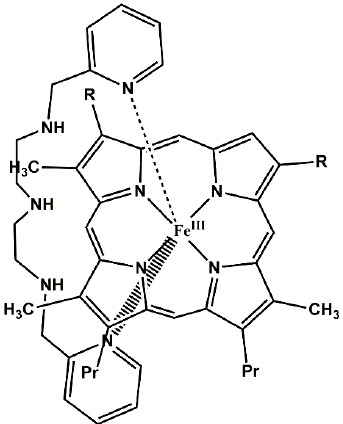
Figure 1. Pinch-porphyrins. When R = –CH=CH 2 FePPPic; R = –CH 2 –CH 3 FeMPPic and -H FeDPPic. Pr = methylpropionate.